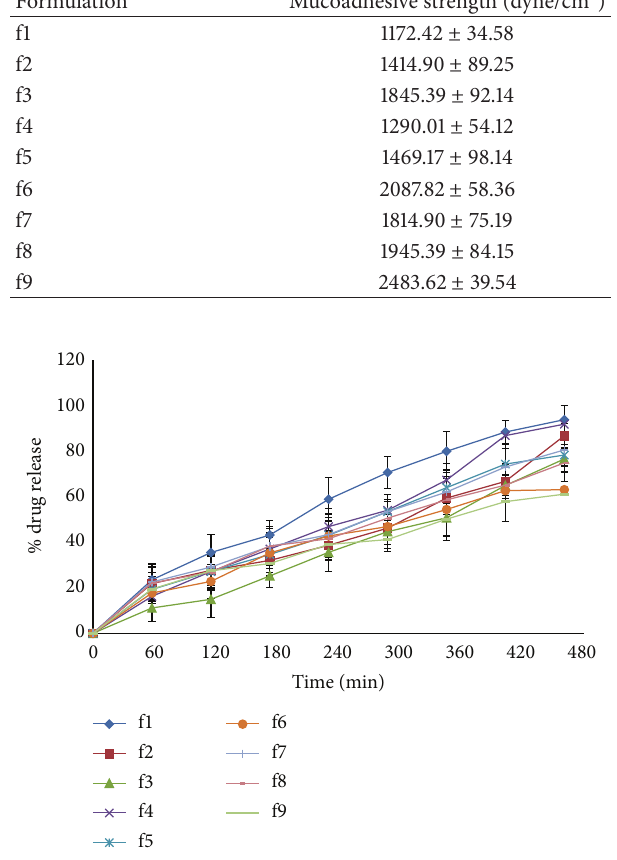
Figure 4: % drug release for formulations